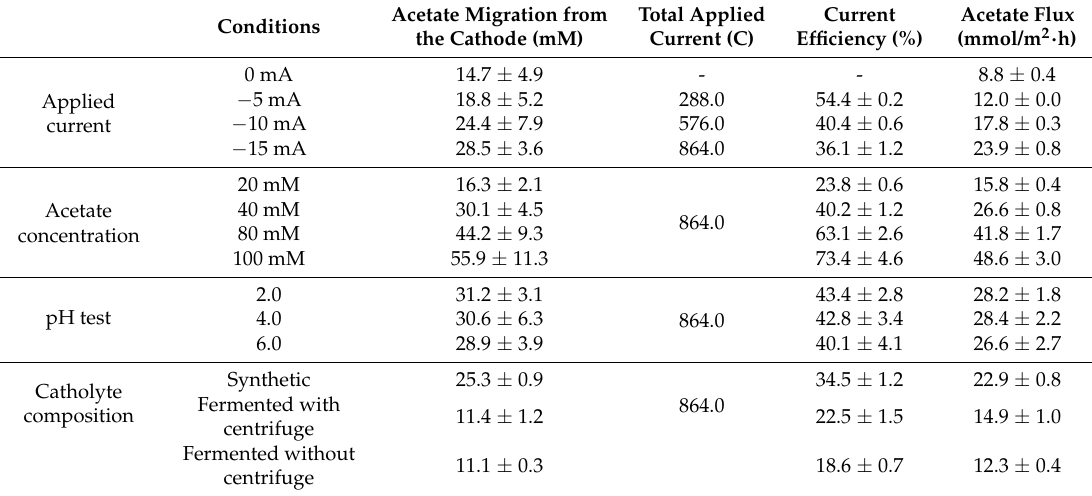
Figure 2. Acetate transfer from the cathode to the anode chamber under different current conditions. Table 1. Entire migration amount of acetate in the cathode chamber, total applied current, current efficiency, and acetate flux.